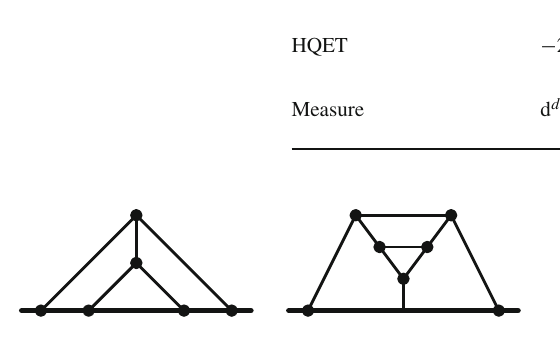
Fig. 3 Examples of on-shell massive diagrams which cannot be trans- formed to off-shell HQET ones by inversion relations